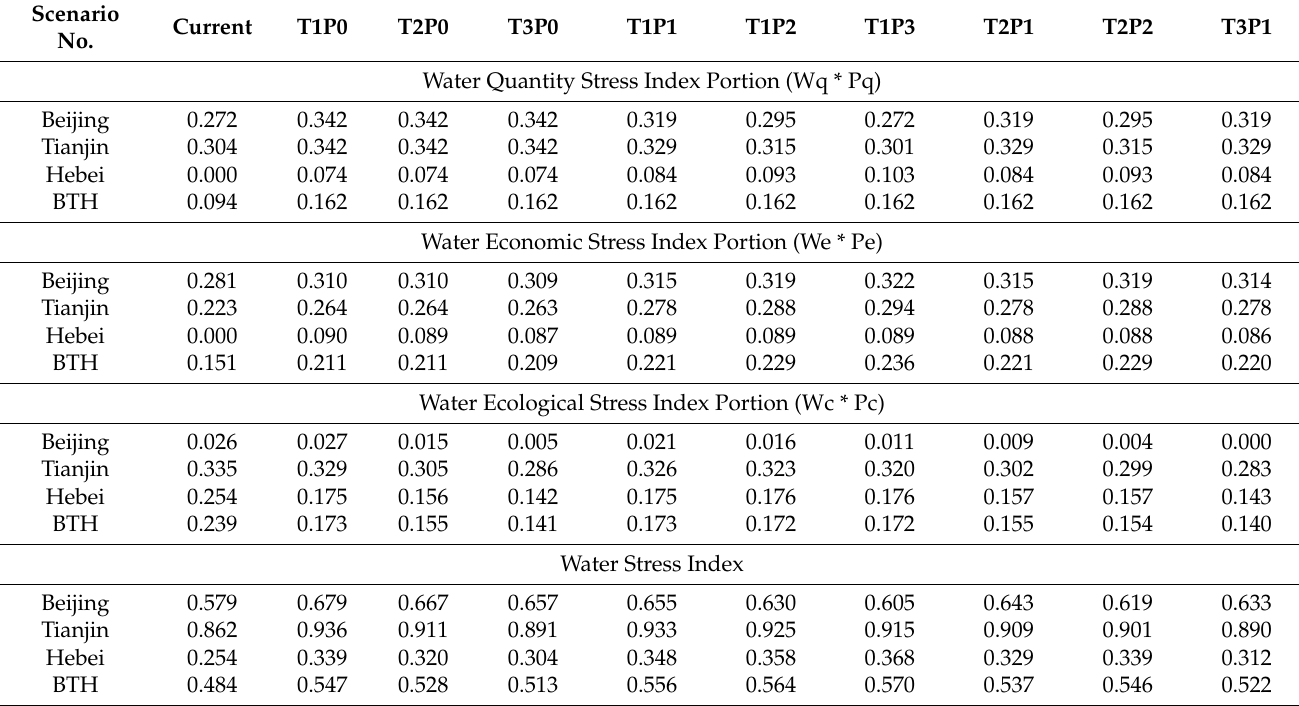
Table 4. Water stress index in different